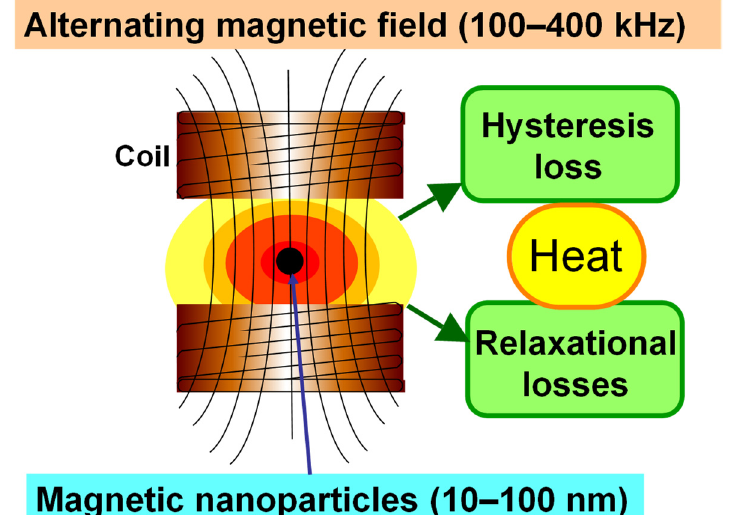
Figure 2. Mechanism of heat generation of magnetic nanoparticles under an alternating magnetic